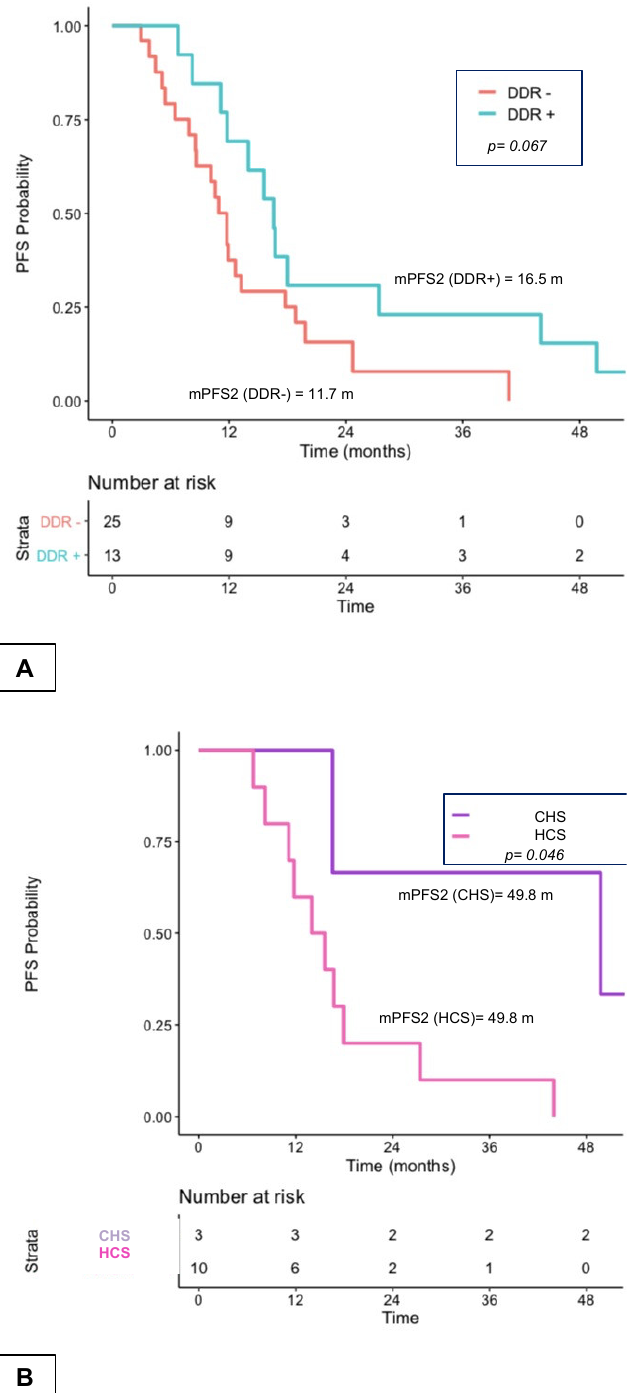
Figure 4. PFS2 according to somatic DDR+ vs. DDR − alterations and among patients who received only CHS or HCS ( A ) and PFS2 among mutated patients who received CHS or HCS according to sequence. ( B ) CHS: chemotherapy followed by NHT sequence; DDR+: mutated patients; DDR − : non-mutated patients; HCS: NHT followed by chemotherapy sequence; m: months; mCRPC: metastatic castration-resistant prostate cancer; median PFS: median progression-free survival; n : number of patients.